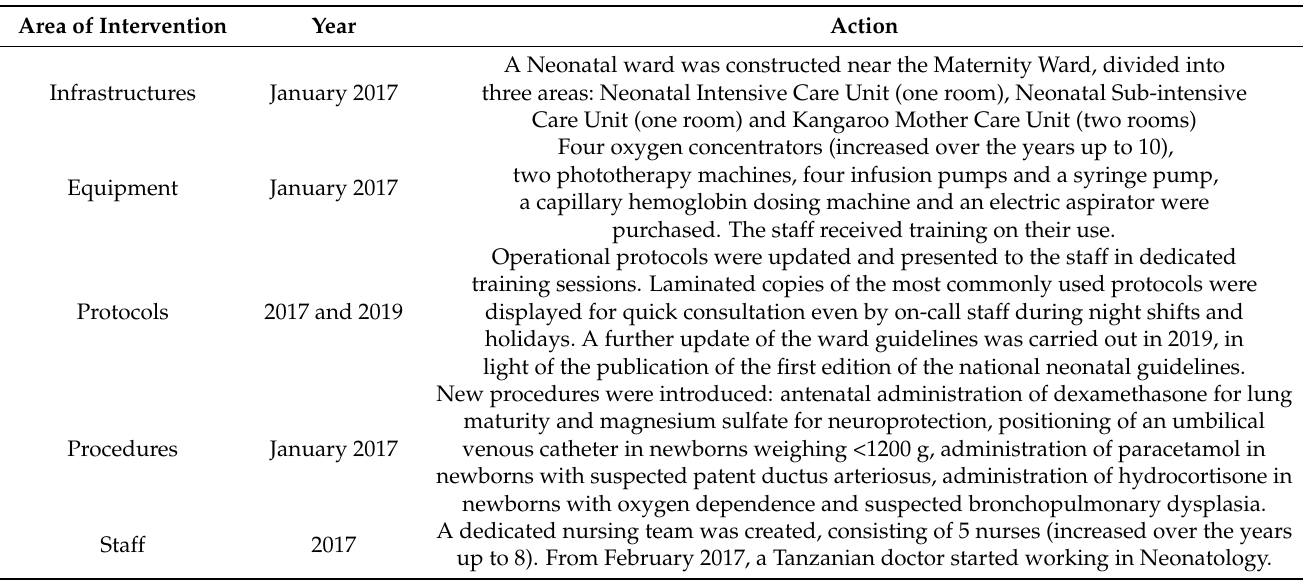
Table 1. Summary of the quality improvement process which was implemented in 2017–2019 at Tosamaganga Hospital (Iringa,